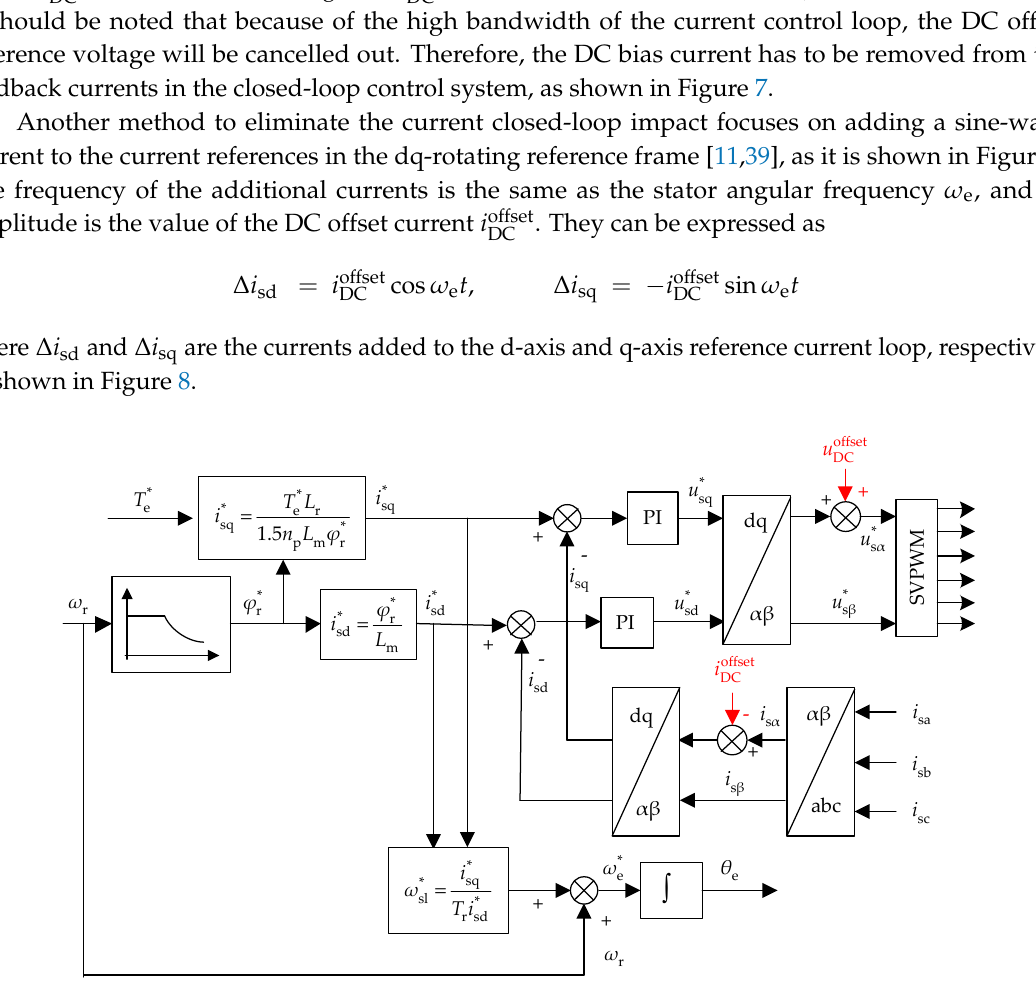
Figure 7. Closed-loop control structure of the motor drive system with the injection of an offset DC voltage for online parameter identification.